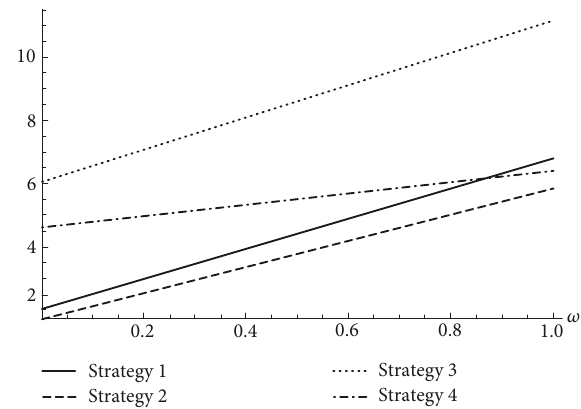
Figure 5: Moviegoers of film series under different star selection